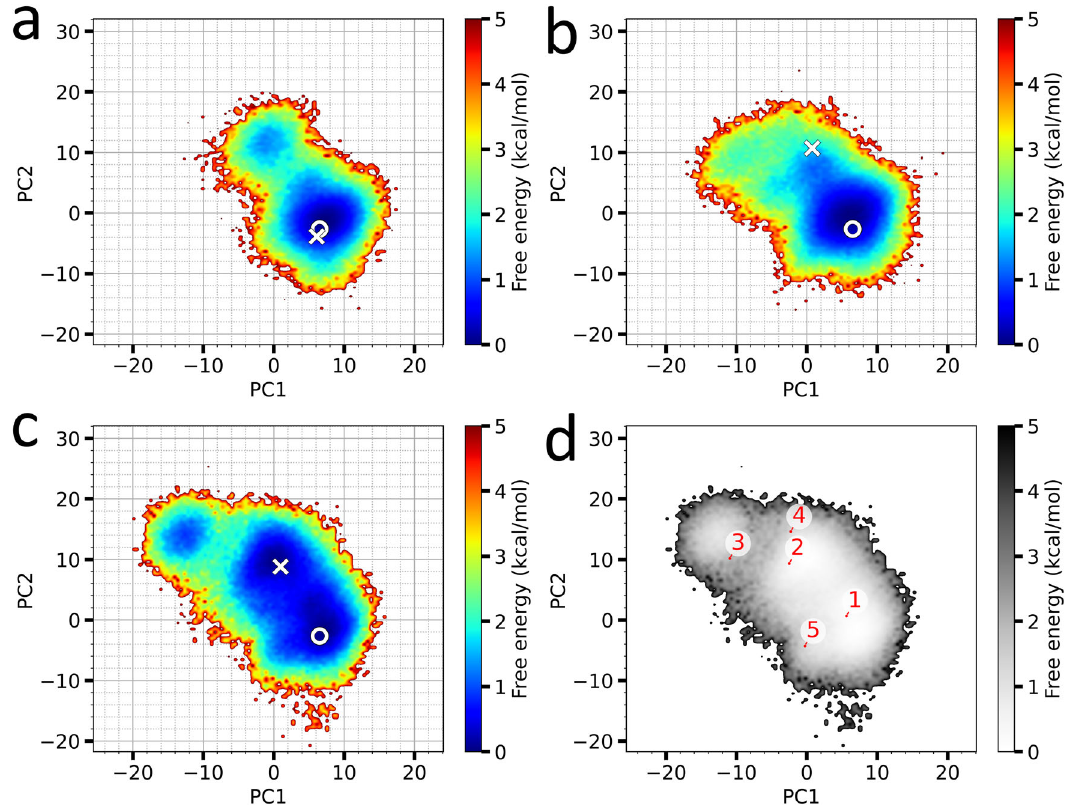
Fig. 4 Free energy landscape of the Bcl-xL receptor protein in the presence of different ligands. The landscapes are shown along the fi rst and the second principal components (PC1 and PC2, respectively), obtained from each system ’ s reweighted (300 K) multicanonical ensemble, with the contour value in kcal/mol. a Bcl-xL conformational landscape in the presence of WEHI-539. b Bcl-xL conformational landscape in the presence of ABT-737. c Bcl-xL conformational landscape in the presence of Bim. d Location of representative structures r bcl k within 2.5 kcal/mol on the Bcl-xL landscape of c . The principal component analysis of Bcl-xL was performed based on the distance matrix calculated from atom pairs constructed from two groups, excluding neighboring residues ( i ± 4). The fi rst group is de fi ned as the C α atoms from residues Ala84 to Tyr195, while the second group is de fi ned as the C α atoms from the residues Ala89, Glu124, Gly147 and Trp181. PC1 and PC2 contribute 15.58% and 9.34%, respectively, to the conformational variance of Bcl-xL. Also indicated in a – c are the apo conformation (initial structure used for the simulations) as a circle and the corresponding holo conformation as a